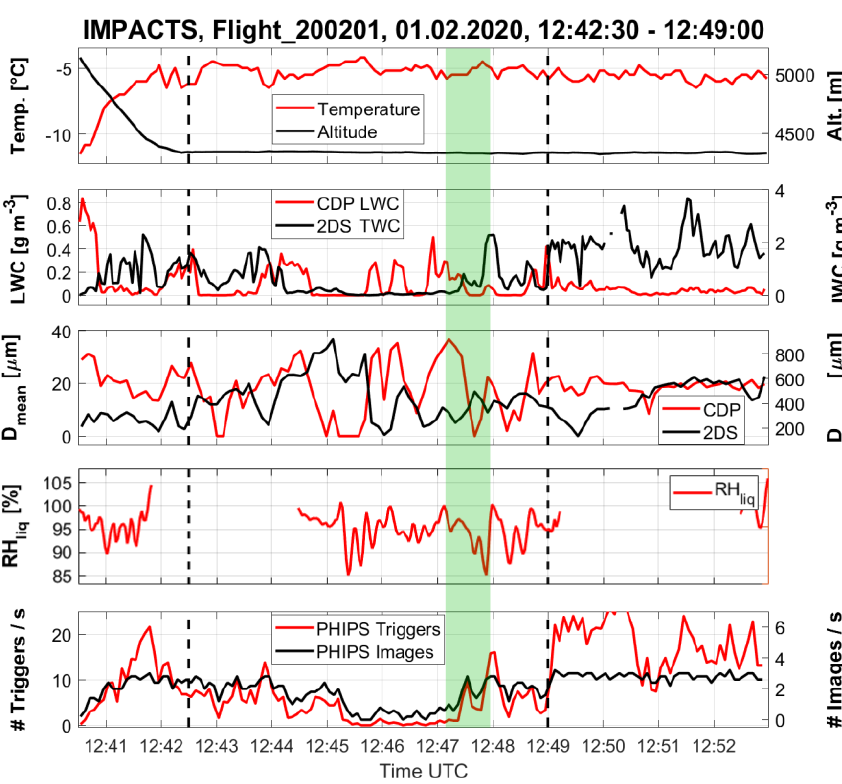
Figure 10. Example of PHIPS data acquired in a mixed-phase cloud near the US east coast sampled during the IMPACTS campaign on 1 February 2020. The graph shows an overview of temperature, altitude, CDP liquid water content, 2DS total water content, CDP and 2DS number-weighed mean particle diameter and number of PHIPS images and total triggers. Corresponding representative PHIPS images of particles sampled during this segment are shown in Fig. 11 The shaded green area marks a 45s segment during which the four particles shown in Fig. 12 were acquired. Table 2. Fit parameters to the riming percentage histograms shown in Fig. 9.